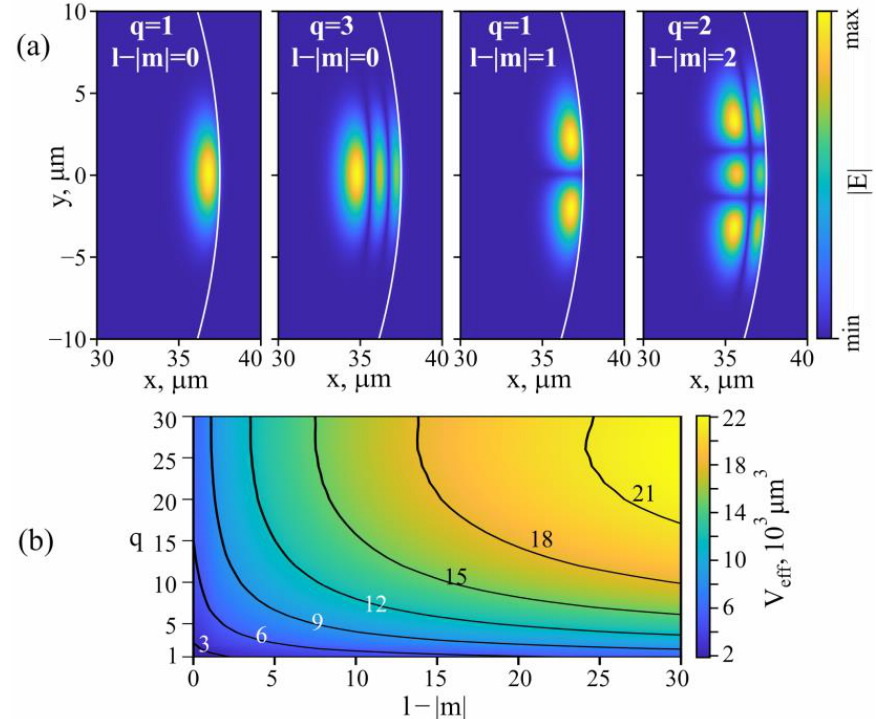
Figure 3. ( a ) Examples of calculated electric fields of eigenmodes with different indices for 75 µm tellurite microsphere resonator. ( b ) Calculated effective mode volume for eigenmodes with different indices for this resonator.